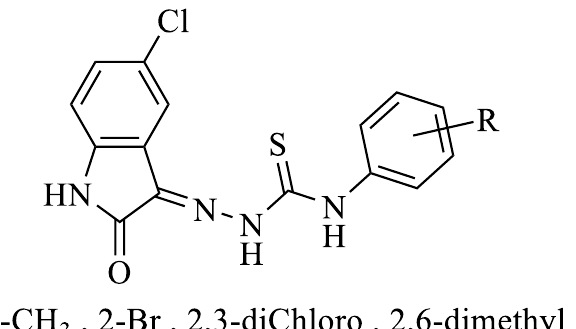
Fig. 8. Isatin derivatives as inhibitor of α-glucosidase enzyme (Rahim et al.,